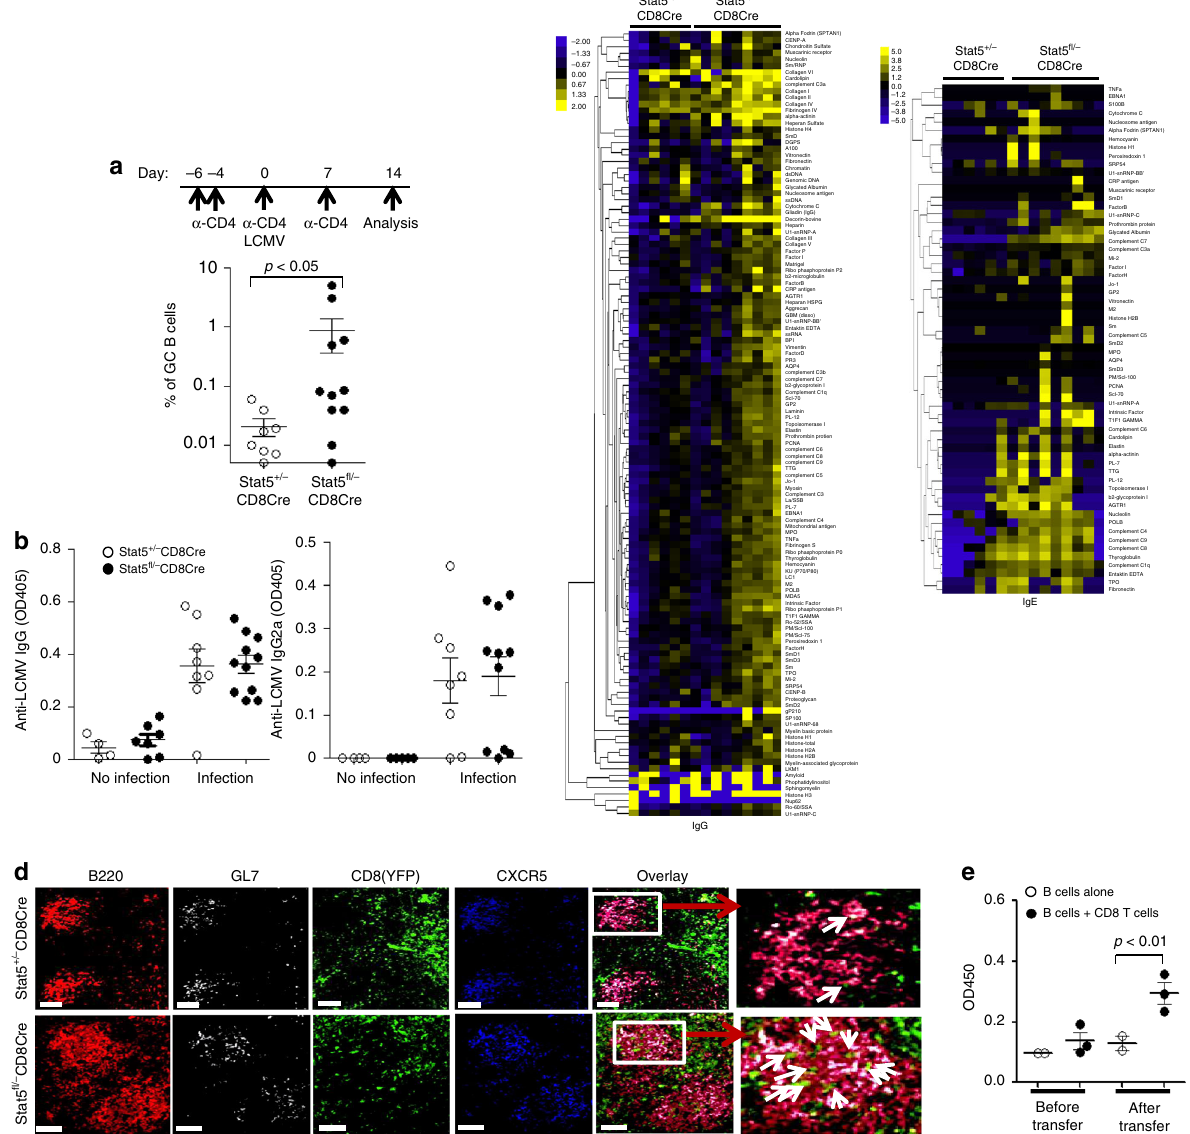
Fig. 4 Increased autoantibody production by CD8 + T-cell-speci fi c deletion of Stat5. a GC B-cell generation in CD4 + T-cell-depleted Stat5 fl / − CD8Cre mice. CD4 + T-cell-depleted Stat5 + / + CD8Cre and Stat5 fl / − CD8Cre mice were infected with LCMV and analyzed 14 days later. The experimental scheme is shown (upper). Dot plots show percentages of Fas + GL7 + cells in the gated B220 + population. Each dot represents an individual mouse and horizontal bars indicate mean values (lower). Mean± SD is shown. b The serum levels of LCMV-speci fi c IgG and IgG2a in CD4 + T-cell-depleted Stat5 + / + CD8Cre and Stat5 fl / − CD8Cre mice. Each dot represents an individual mouse and horizontal bars indicate mean values. Mean± SD is shown. c Markedly increased autoantibodies in CD4 + T-cell-depleted Stat5 fl / − CD8Cre mice following acute LCMV infection. Following LCMV infection, the sera from CD4 + T-cell- depleted mice were screened by the autoantigen array. d Increased GC localization of CD8 T-cells in Stat5-de fi cient mice. The spleen sections from LCMV- infected Stat5 + / + CD8CreYFP or Stat5 fl / − CD8CreYFP mice were stained with antibodies against B220 (red), GL7 (white) and CXCR5 (blue), and imaged using the Nikon Inverted Microscope. The examples of YFP + CD8 T cells in GC were pointed out by the white arrows. Data shown are representative of three Stat5 + / + CD8CreYFP and two Stat5 fl / − CD8CreYFP mice. Scale bars, 100 μ m. e Promoting B cells to produce autoantibodies by CD8 T cells in vivo. CD8 T cells sorted from LCMV-infected wild-type mice were adoptively transferred into Rag1-de fi cient mice with B cells. The recipients were infected with LCMV and 2 months later, anti-nuclear antibodies (ANA) were measured. Each dot represents the level of ANA in an individual recipient before or after adoptive transfer of the indicated cells and horizontal bars indicate mean values. Mean ± SD is shown. Statistical analysis was performed with the Mann – Whitney test ( a ) or the unpaired two-tailed Student ’ s t -test ( b , e ). Data shown are obtained from or representative of 8 ( a , b ), 6 ( c ) or 3 ( d ) Stat5 + / + CD8Cre/ YFP and 11 ( a , b ), 9 ( c ) or 2 ( d ) Stat5 fl / − CD8Cre/YFP mice. Source data are available as a source data fi